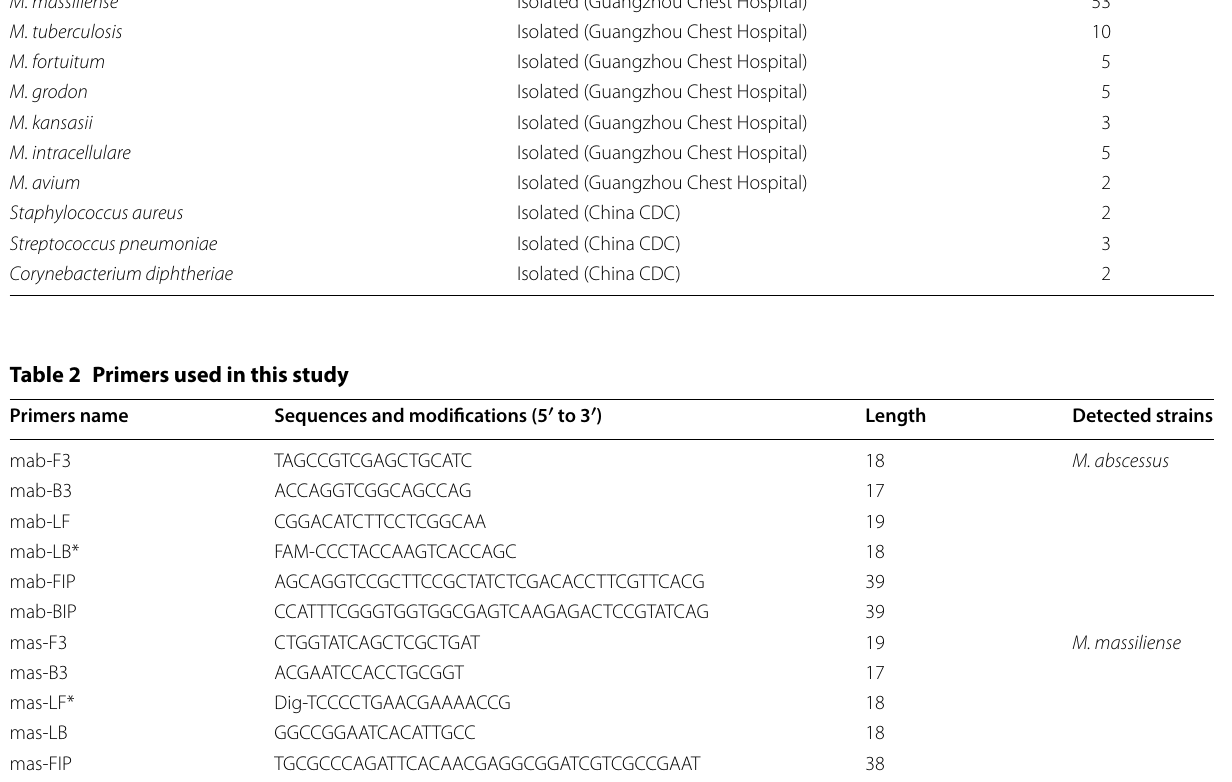
primer sequences, and positions are displayed in Table 2 and Fig. 1, while the schematic diagram of M. massil- iense -LAMP primers inability to amplify the M. abscessus erm (41) sequence is displayed in Fig. 2.